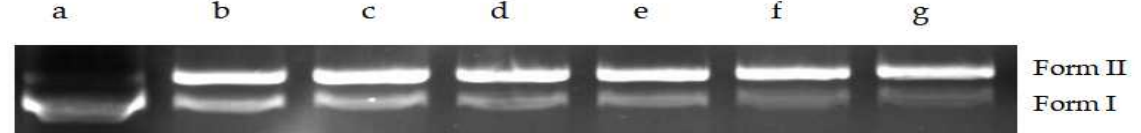
Figure 12. Effect of DNA topoisomerase on pET-28a DNA helicase. Note: Form II (open circular DNA and linear); Form I (supercoiled DNA); a: pET-28a; b–g: 2 µL; 2.8 µL; 3.6 µL; 4 µL; 6 µL; 8 µL DNA Topoisomerase extract.